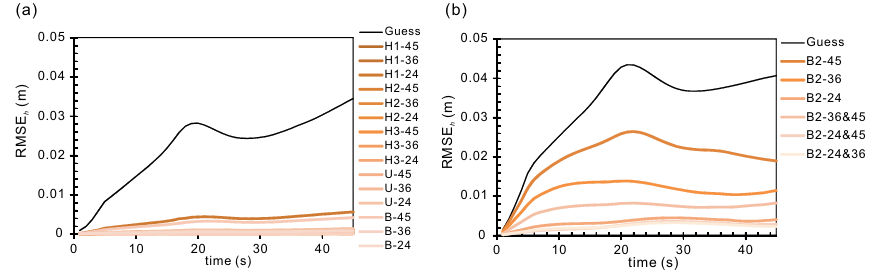
Figure 7. The time series of RMS errors of water depth (RMSE h ) in assimilation experiments with (a) lumped Manning’s n , and (b) dis- tributed Manning’s